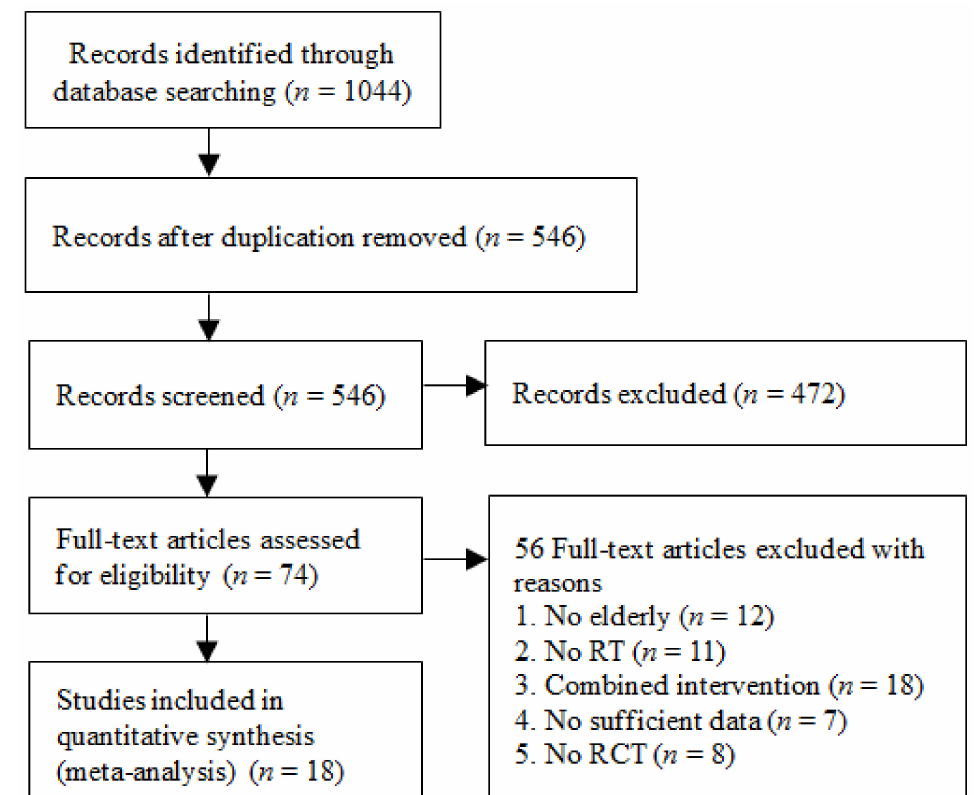
Figure 1. Flow diagram of the study selection